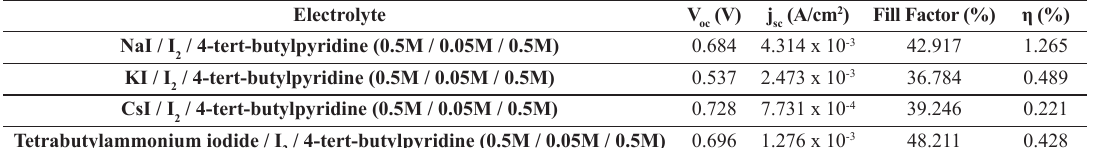
Table 8. j x V curve results of cells employing or not 4-tert-butylpiridine in the electrolyte. Electrolyte